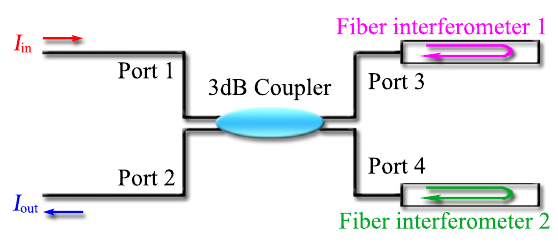
Figure 1. Vernier effect fiber sensor with two parallel connected